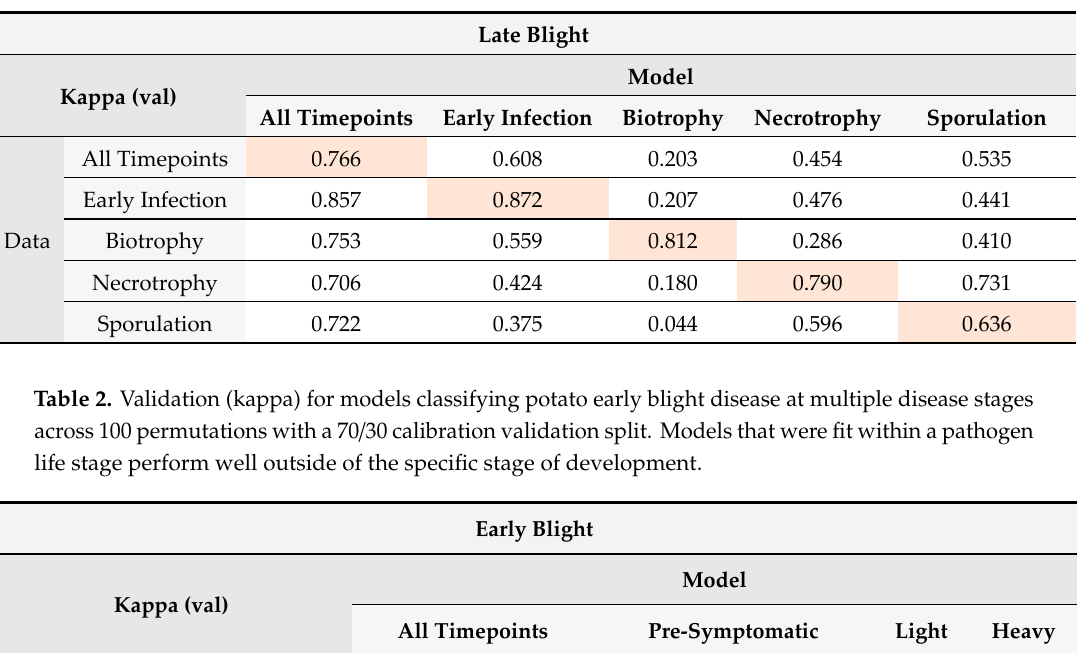
Table 1. Validation (kappa) for models classifying potato late blight disease at multiple life stages across 100 permutations with a 70 / 30 calibration validation split. Models that were fit within a life stage do not perform well outside of that stage of development with the exception of the sporulation model. Remote Sens. 2020 , 12 , 286